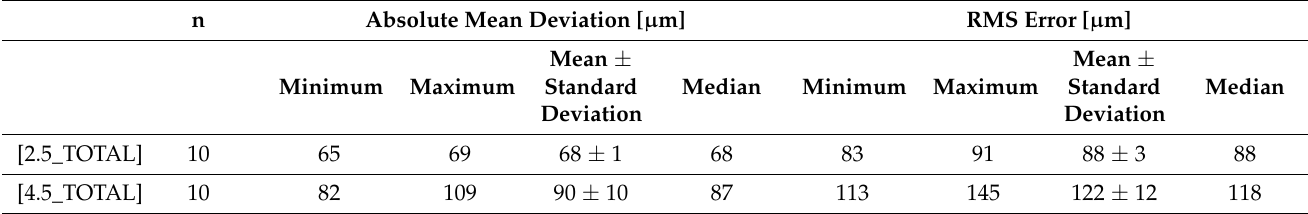
Table 4. Trueness [2.5_TOTAL] and